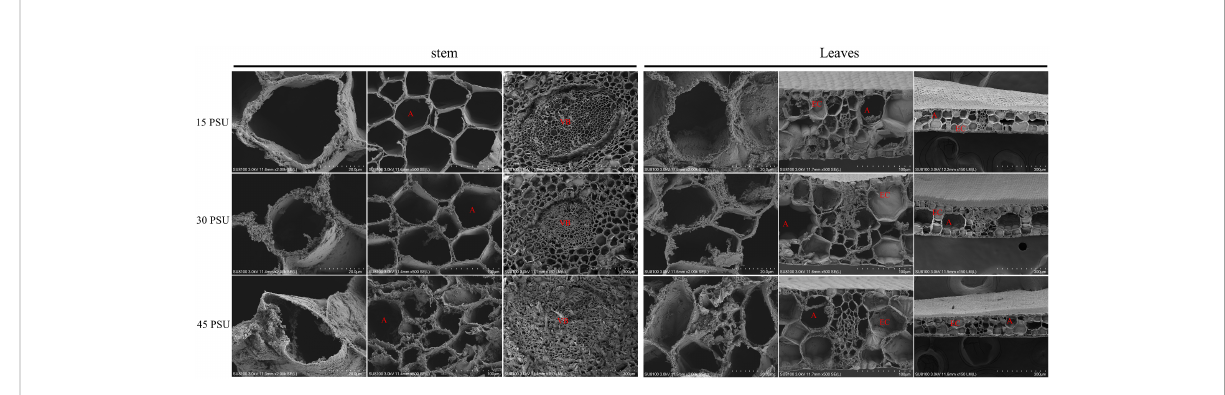
FIGURE 2 Comparative analysis of the internal structure of stems and leaves at 15 PSU, 30 PSU, and 45 PSU salinity stress by scanning electron microscope (SEM). (A) Aerenchyma; (VB) Vascular bundle; (EC) Epidemic